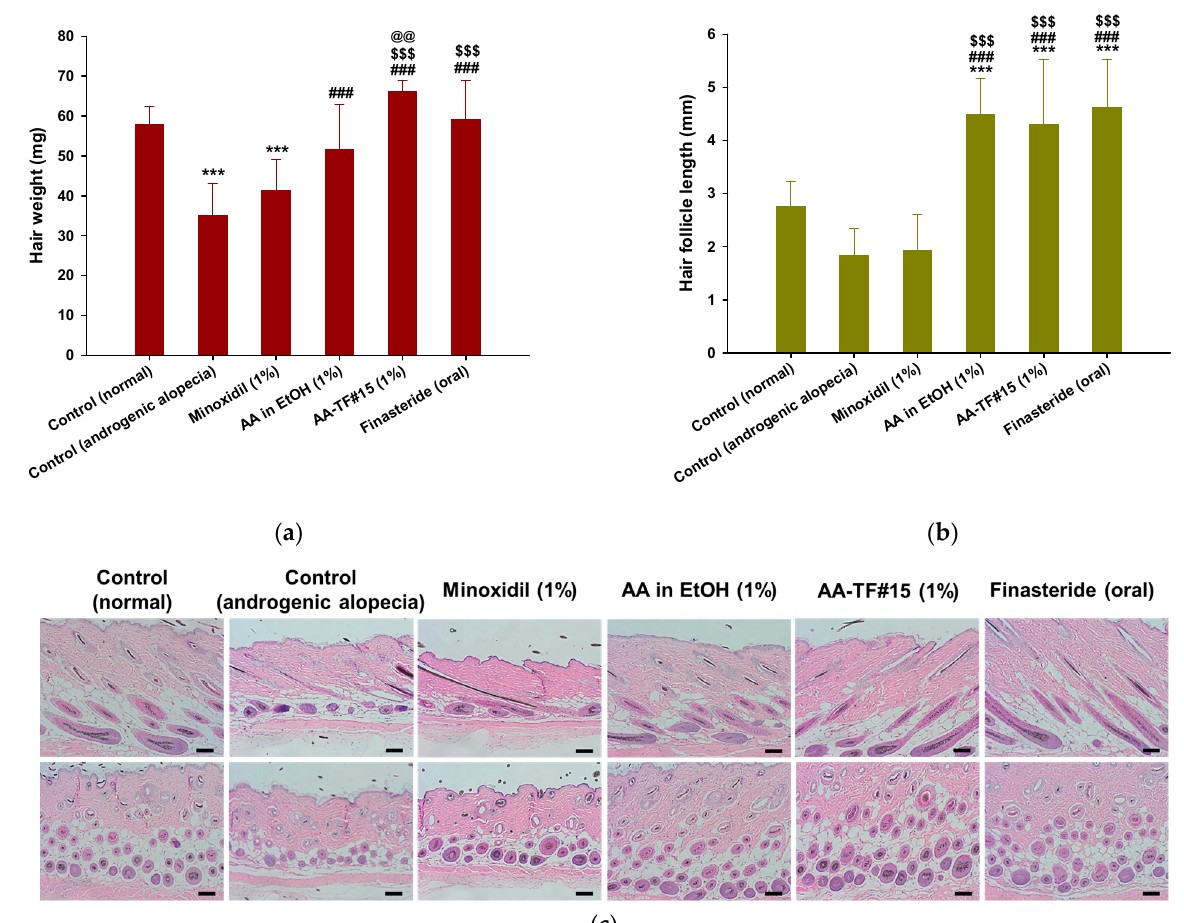
Figure 7. ( a ) Hair weight from each group at 18 days after treatment; ( b ) Hair follicle length from each group after 18 days of treatment. *** p < 0.001 compared to control (normal); ### p < 0.001 compared to control (androgenic alopecia); $$$ p < 0.001 compared to minoxidil (1%); @@ p < 0.01 compared to AA in EtOH (1%). Values are presented as mean ± SD ( n = 8 for each group); ( c ) Representative light micrographs of longitudinal and transverse sections of androgenic alopecia skin stained with hematoxylin and eosin (H&E) for quantitation of follicle number and diameter. Scale bar = 100 µm.